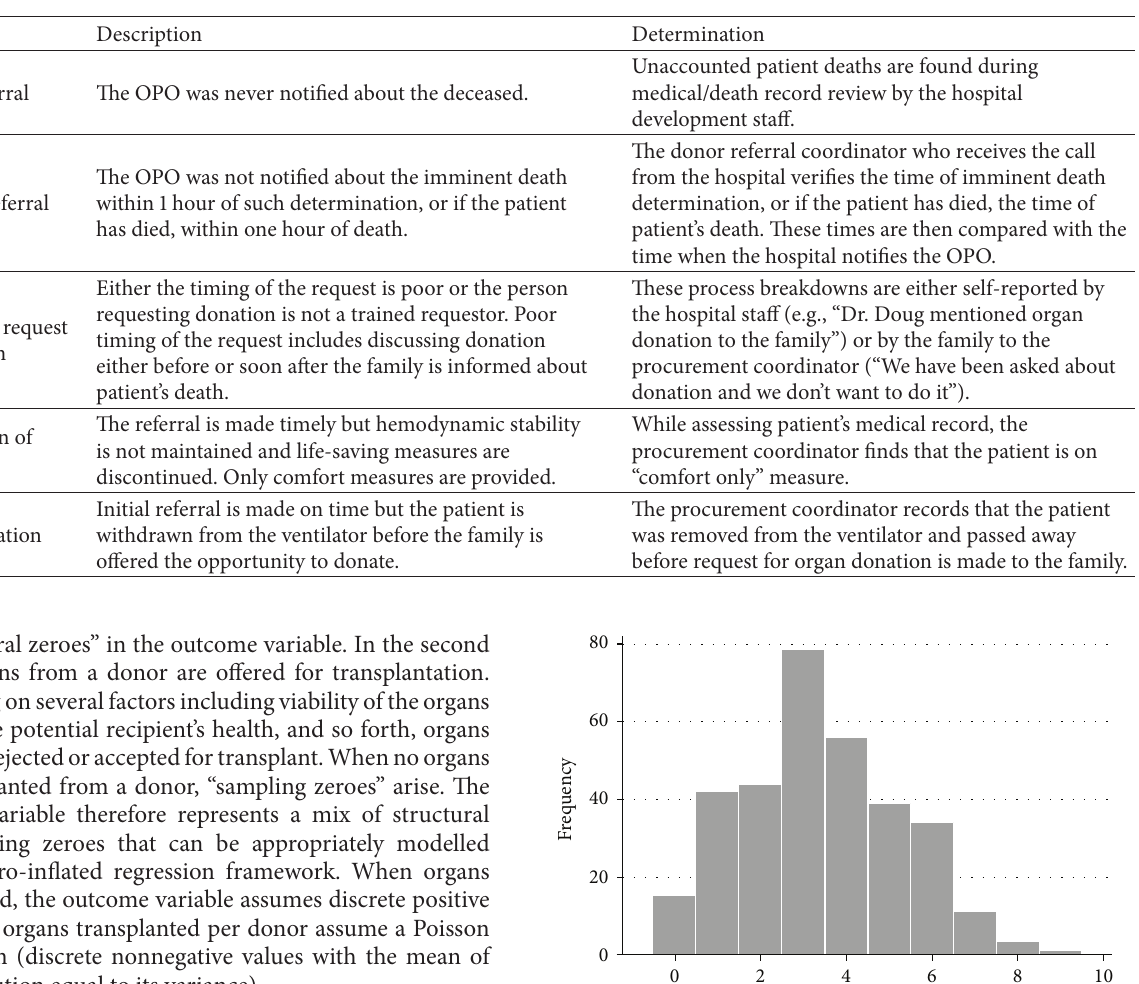
Table 1: Process breakdowns and determination criteria.